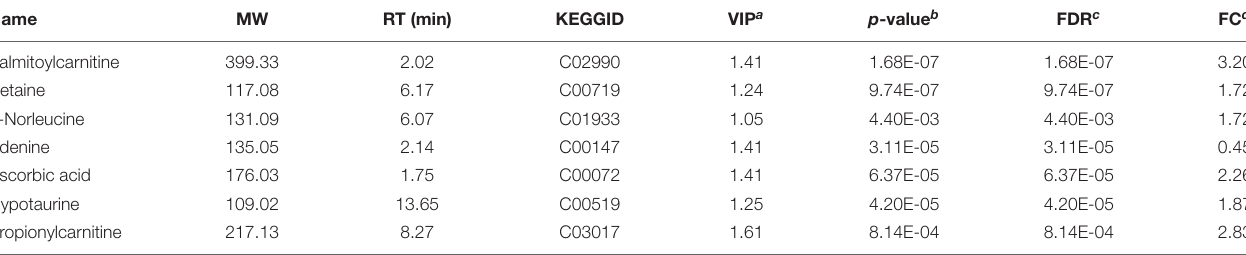
TABLE 2 | List of significant metabolites identified from the orthogonal partial least-squares discriminant analysis (OPLS-DA) mode for the hippocampus.